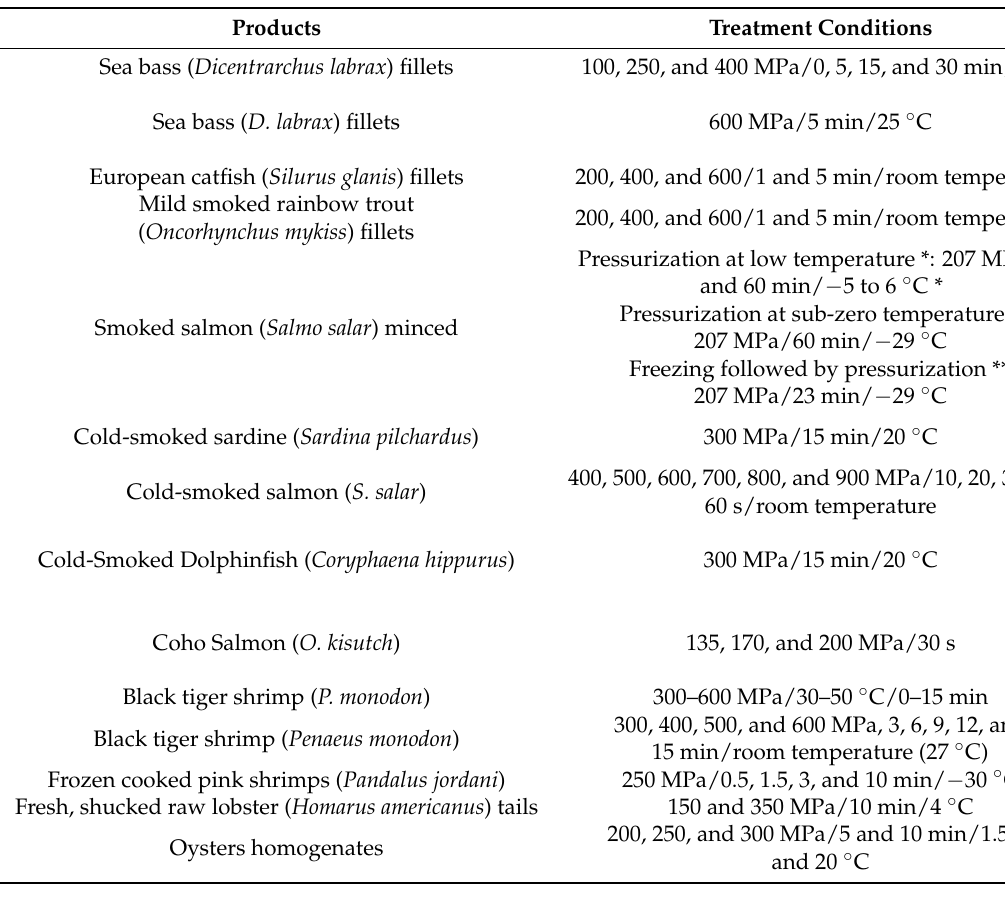
Table 1. Studies on the application of high hydrostatic pressure (HHP) treatment on fish and seafood